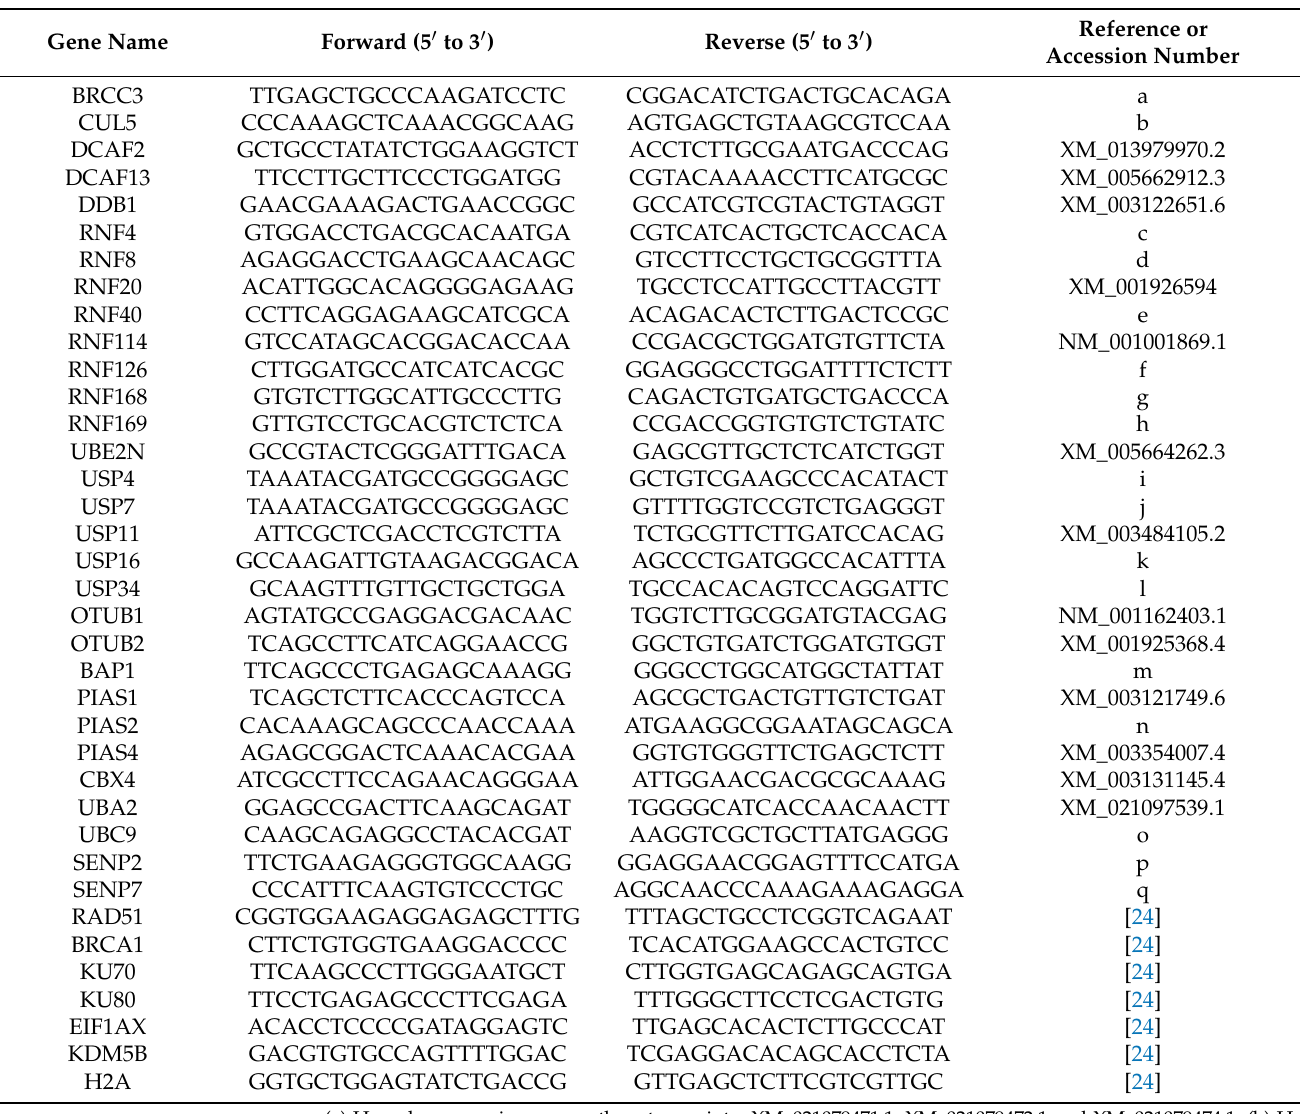
Table 2. Primers used in the quantitative real-time PCR